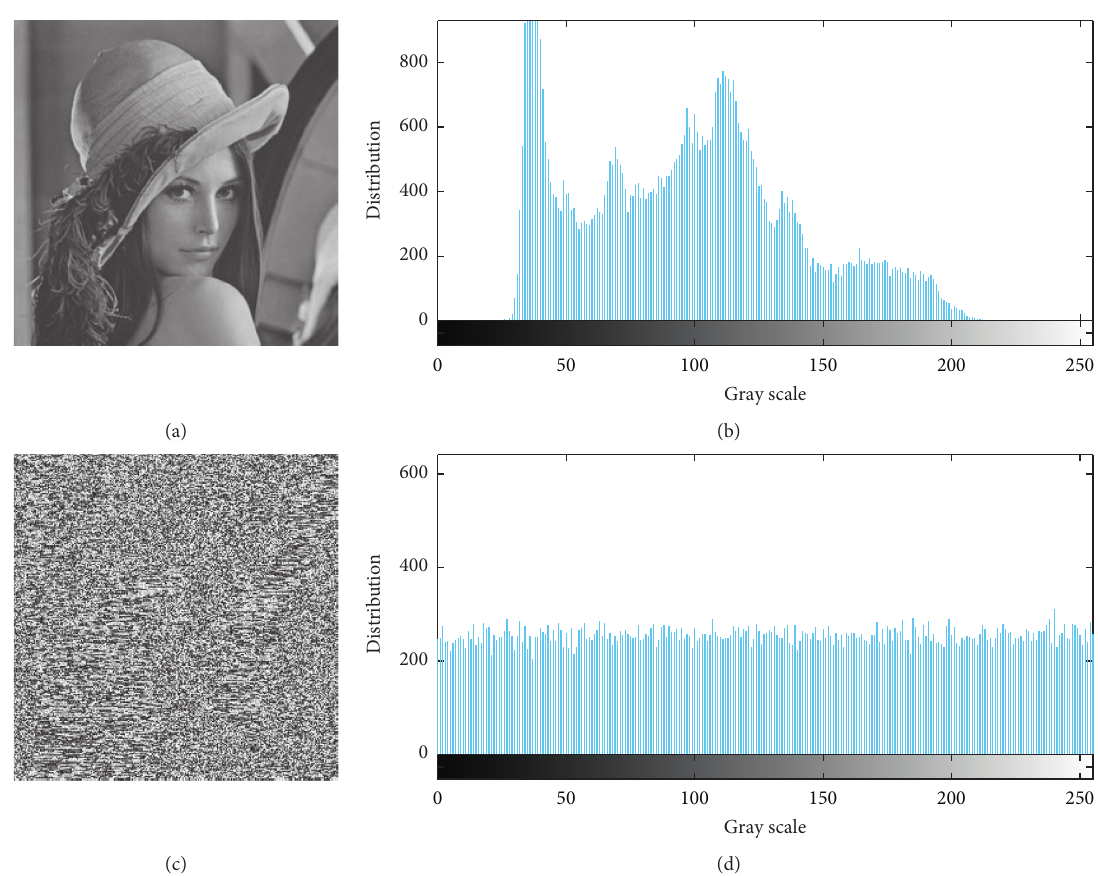
Figure 7: Histogram analysis. (a) The plain image. (b) The histogram of the plain image. (c) The cipher image. (d) The histogram of the cipher